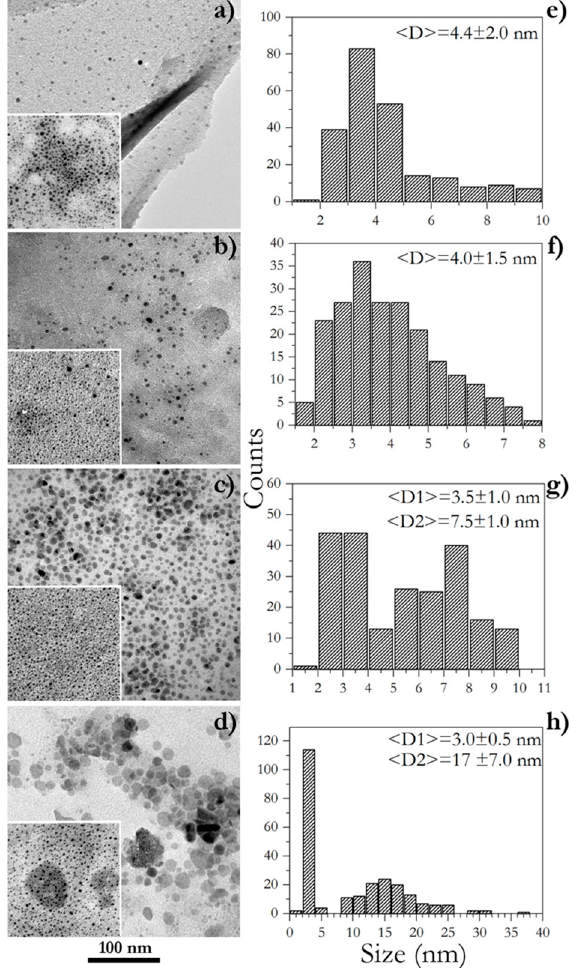
Figure 2. TEM analysis of Ir-NP1 ( a ), Ir-NP2 ( b ), Ir-NP3 ( c ), and Ir-NP4 ( d ), and the corresponding histograms of their size distributions ( e – h ).